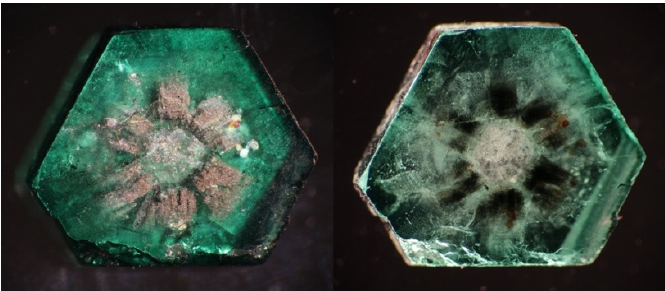
Figure 2. This chosen sample in this study, weighing 0.535 ct, with a size of 6.32 × 5.65 × 1.56 mm 3 , shows a trapiche pattern consisting of a minute black inclusion surrounding a colorless core.